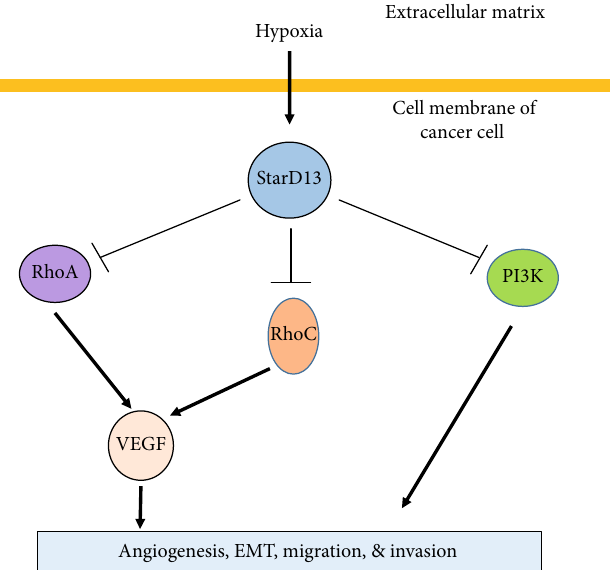
Figure 1: VEGF expression is regulated by Rho GTPases in cancer cells. RhoA, RhoC, and PI3K are involved in VEGF expression in cancer cells leading to angiogenesis and migration. Downregulation of VEGF during hypoxia is due to the overexpression of StarD13 (Rho GAP) which inhibits the activity of Rho A, RhoC, and